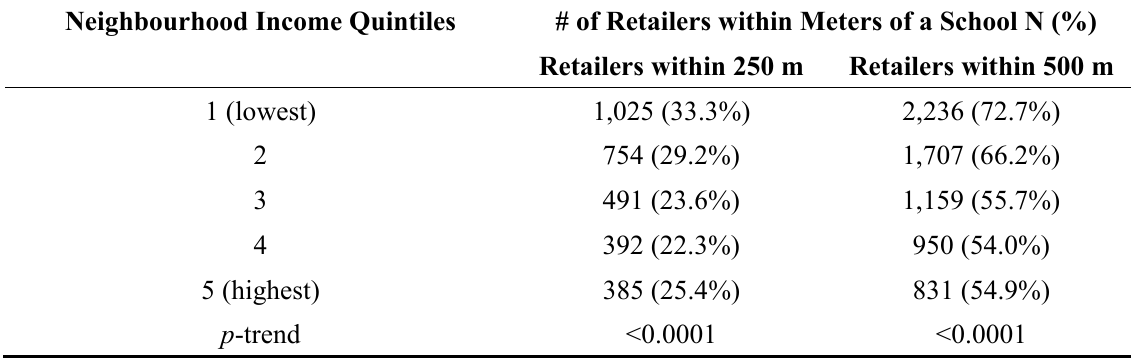
Table 4. Percent of retailers with one or more schools within walking distance (250 or 500 m), by neighbourhood income quartile ( n = 11,013 retailers *